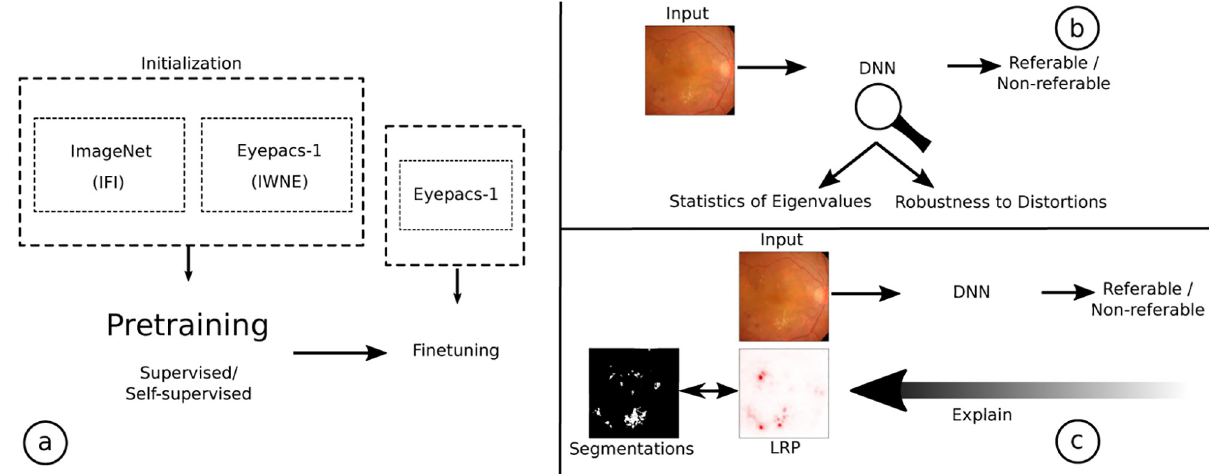
Fig 1. Overview of the experiments presented in this work. a) shows the different pretraining strategies: Initialization from ImageNet (IFI) [9] and Initialization without any external data (IWNE), i.e. pretraining only on Eyepacs-1 datasets [10]. Such a pretraining step can be performed either in a supervised or a self-supervised manner. This is followed by finetuning on the Eyepacs-1 dataset. b) investigates the statistics of the eigenvalues of the feature representations learned by the different methods which lead to increased robustness to distortions. c) shows the experiments we perform using the Indian Diabetic Retinopathy Image Dataset (IDRiD) challenge data [11] to quantitatively evaluate the cues learned.